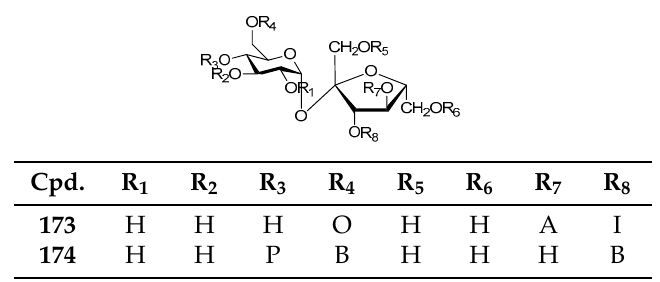
Figure 19. Structures of compounds 169 – 172 .